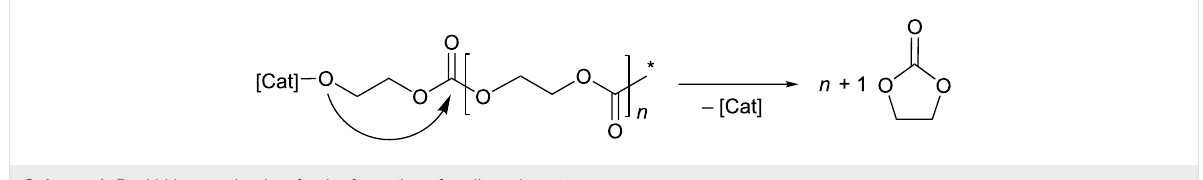
Scheme 4: Backbiting mechanism for the formation of cyclic carbonates.